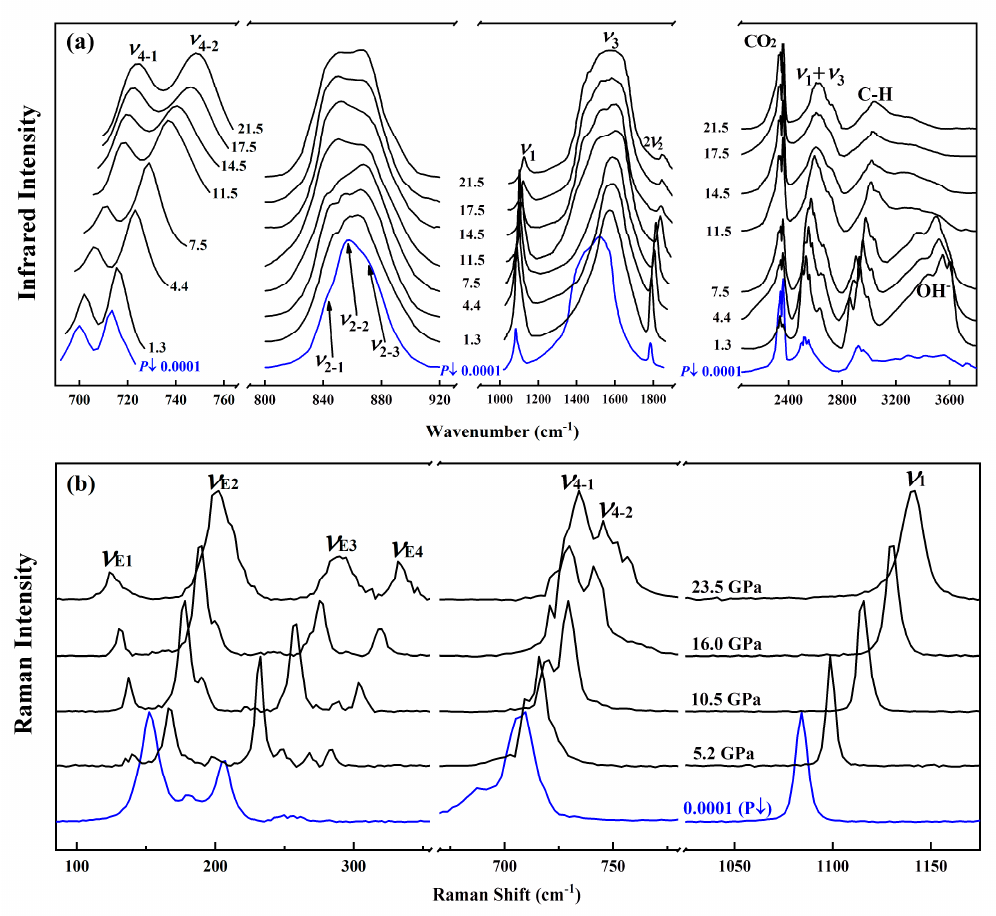
Figure 4. ( a ) Infrared and ( b ) Raman spectra of aragonite as a function of pressure with the background subtracted. The spectra labeled by P ↓ was collected after decompression. In ( b ), the scale of the lower-wavenumber data ( < ~800 cm − 1 ) has been trebled for greater clarity.